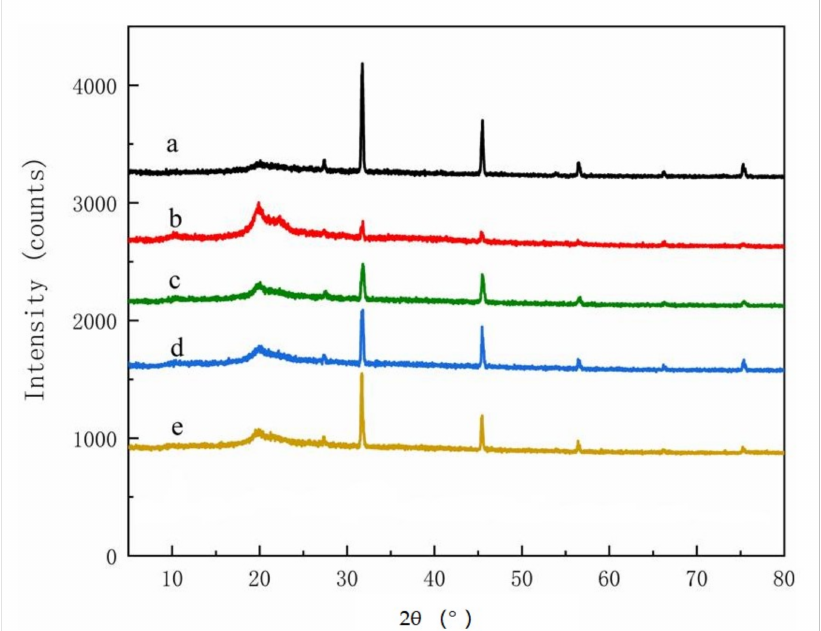
Figure 6. XRD spectra of CMCs derived from ( a ) pine wood, ( b ) bamboo culm, ( c ) pine needles, ( d ) bamboo leaves, or ( e ) hemp